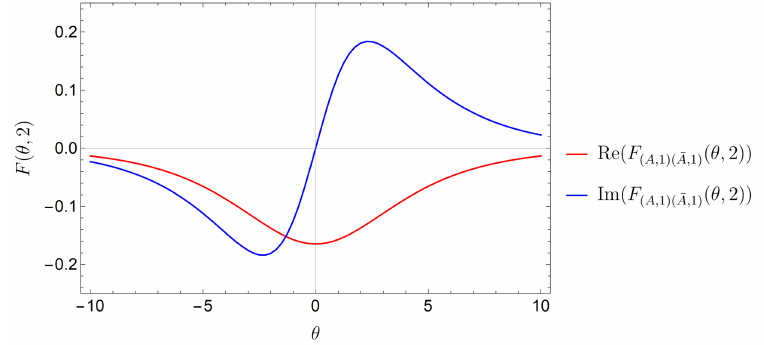
Figure 2 . Two-particle form factors of the standard twist field T n for n = 2 replicas. This figure shows the real and the imaginary parts of the A ¯ A form factor, which equal those of the ¯ AA FF, for real values of the rapidity difference θ . They both go to zero when θ → ±∞ .